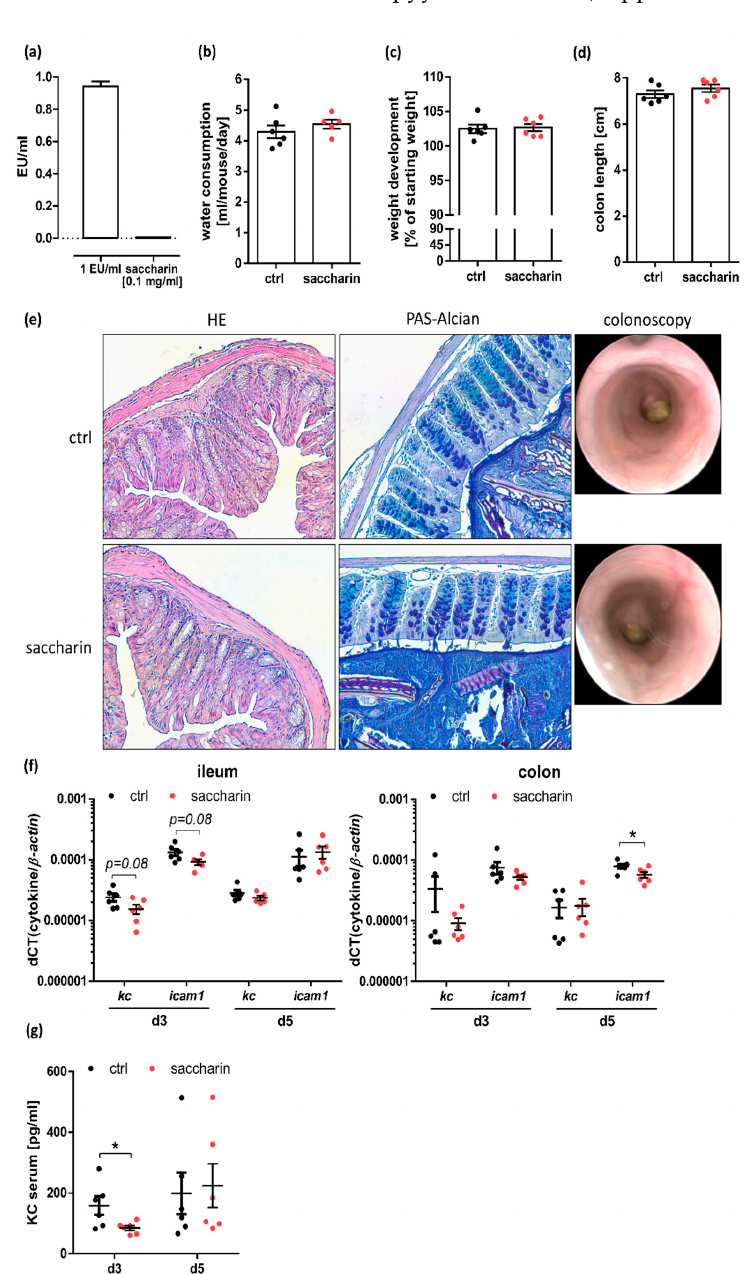
Figure 2. Short-term saccharin supplementation does not lead to intestinal barrier dysfunction but even lowers expression of inflammatory marker in mice. ( a ) Endotoxin units (EU) of applied